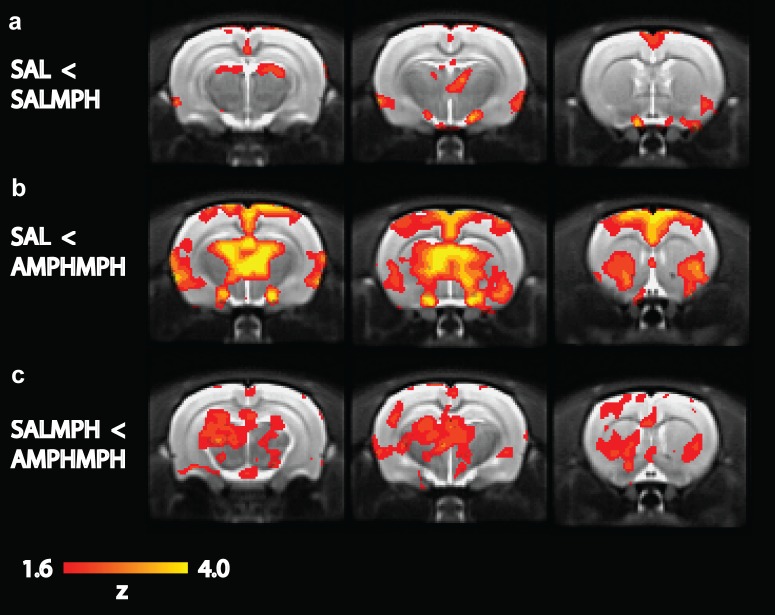
Whole brain analyses of phMRI data.The three rows show 1 mm-thick coronal slices for different group comparisons: a) MPH challenge in saline-treated rats increased BOLD response compared to groups that received a saline challenge b) MPH challenge in AMPH-pre-treated rats increased the BOLD response extensively c) AMPH-pre-treated rats show increased BOLD response compared to the SALMPH group. Images are thresholded at Z = 1.6.